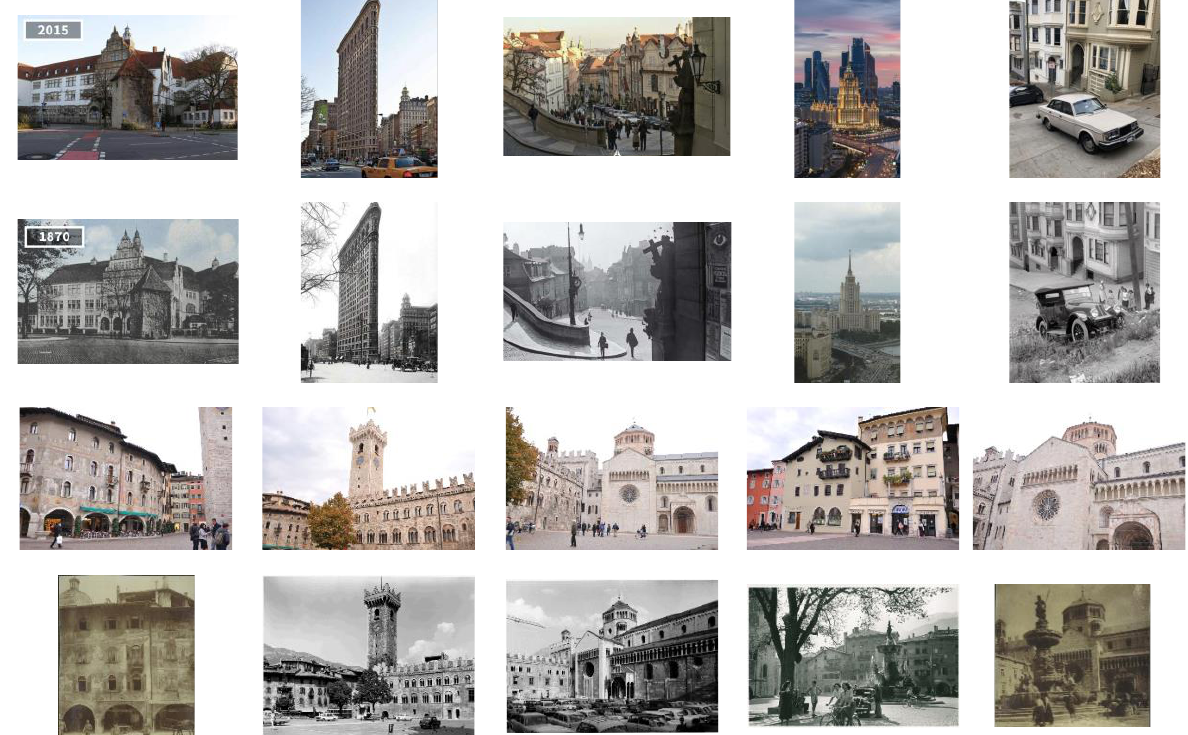
Figure 1: Multi-temporal images employed in this work for the evaluation of hand-crafted and learning-based tie points. “now” and “then” image pairs are shown in the odd and even rows, respectively. The first two rows, from left to right depict scenes from Osnabrück 1 , New York 2 , Prague 1 , Moscow 2 and San Francisco 2 , the last two rows refer to the main square in Trento